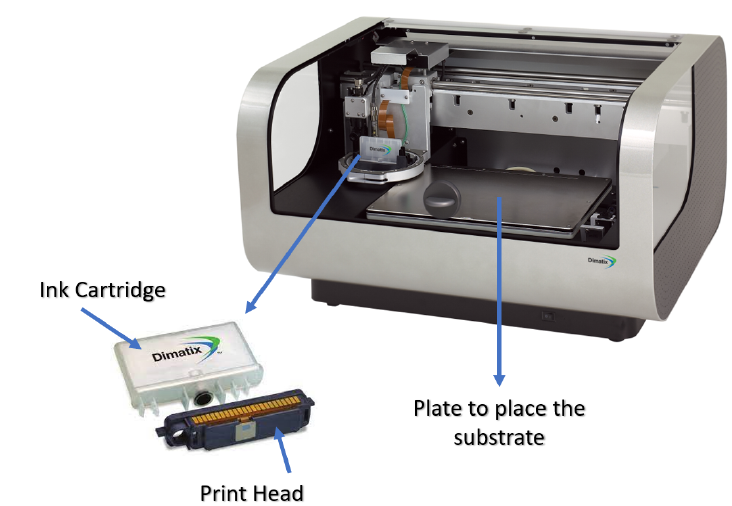
Figure 4. Main components in inkjet printing processes: inkjet printer, ink, and